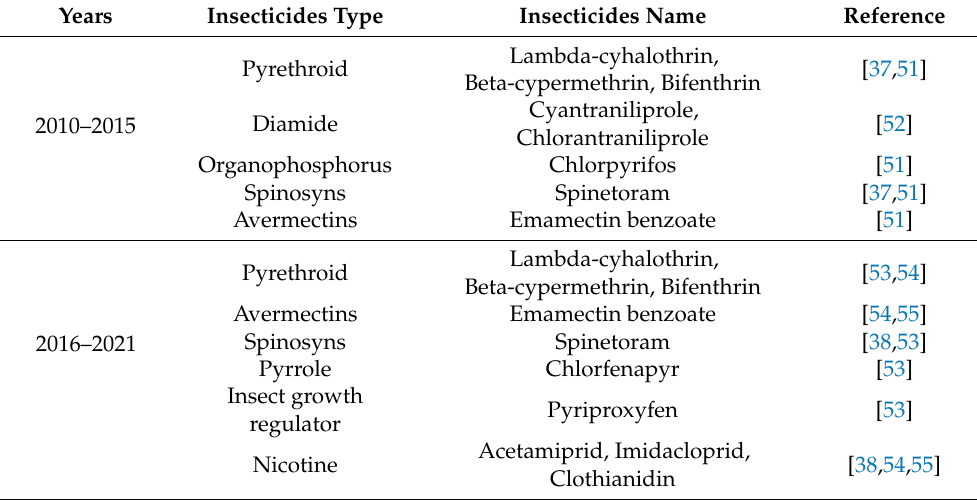
Table A1. Insecticides commonly used in the field to control M. usitatus in the past ten